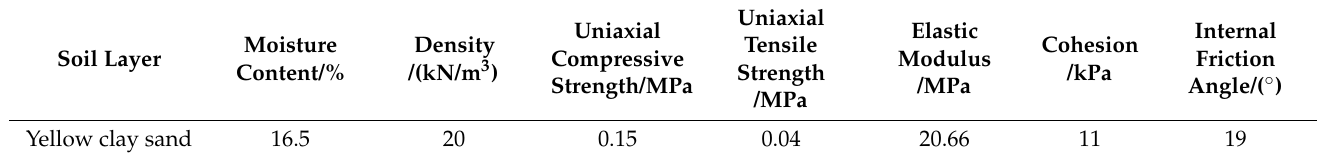
Table 1. Physical and mechanical parameters of yellow clay